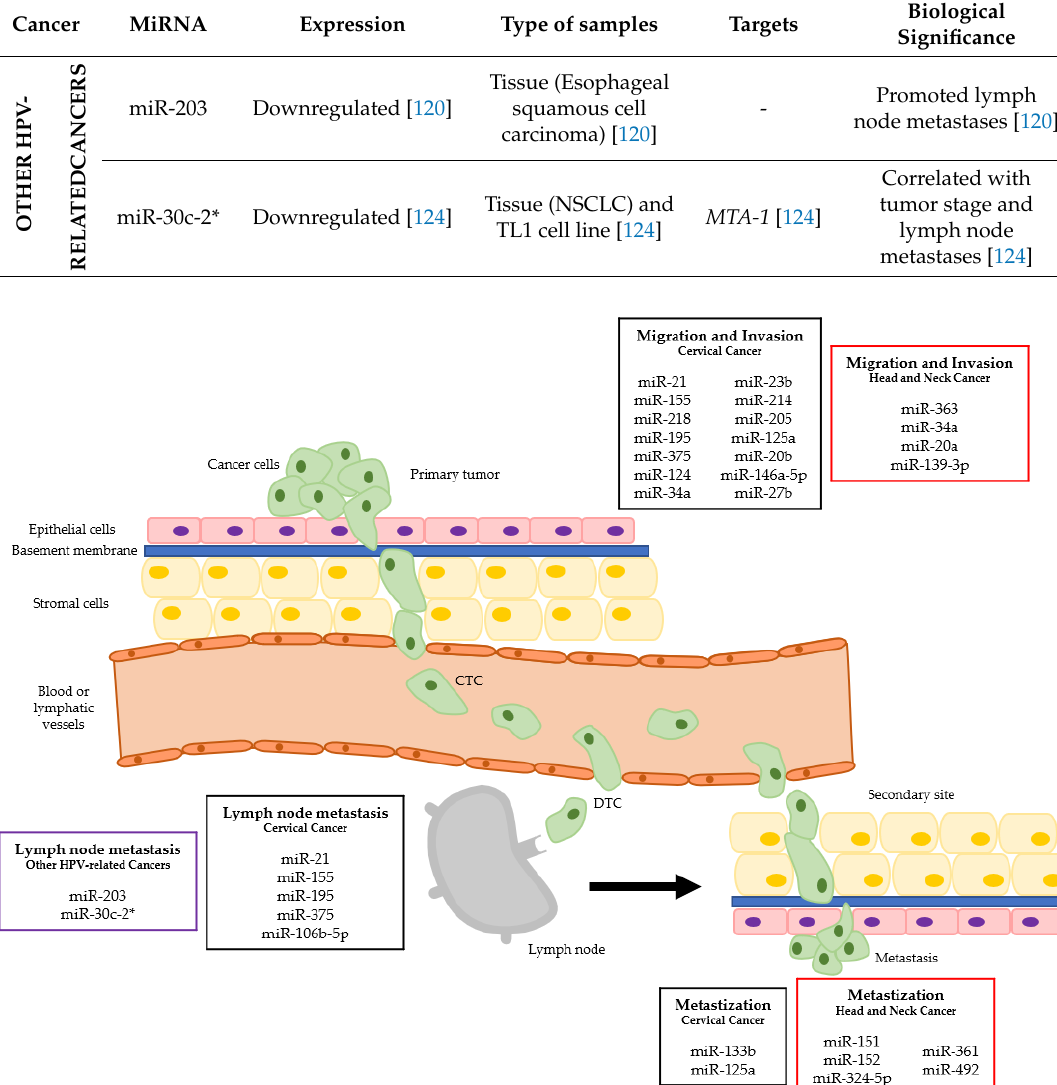
Figure 1. MiRNAs dysregulation in the different metastatic steps of HPV-related cancers. (CTC—circulating tumor cell; DTC—disseminated tumor cell; squares in black refer to cervical cancer, in red to head and neck cancer and in purple to other HPV-related cancers).